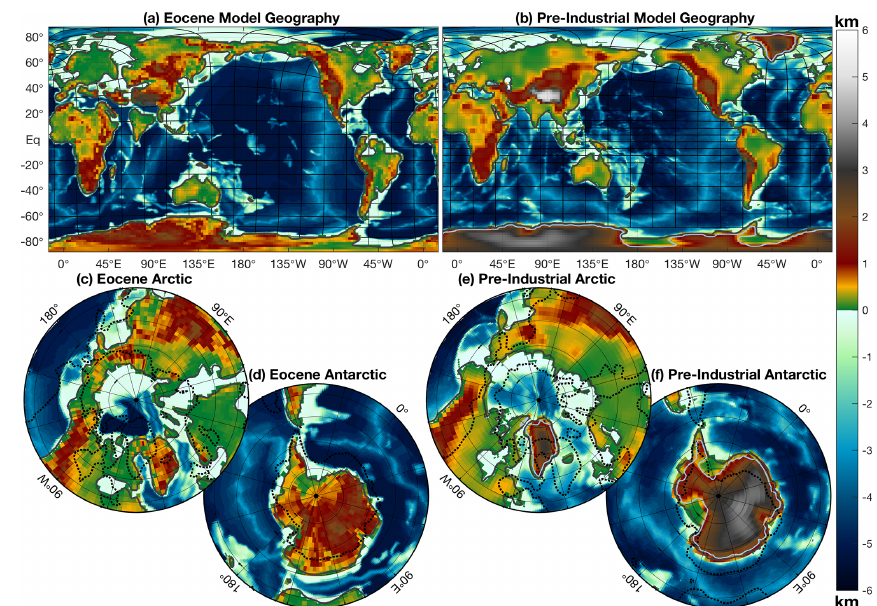
Figure 1. Topography (atmosphere) and bathymetry (ocean) grid used in the model simulations for the (a) 38Ma Eocene cases and (b) pre-industrial reference. Black lines are drawn every 20 model grid boxes for the ocean, and the thick grey line shows the coastlines defined as the 0.5 land fraction. Polar stereographic projections of the Eocene model geography are shown for (c) the Arctic and (d) the Antarctic region, similarly for the pre-industrial one in (e) and (f) , respectively. Dashed black lines indicate the coastlines of the alternative geography, and light blue contours show the edges of ice